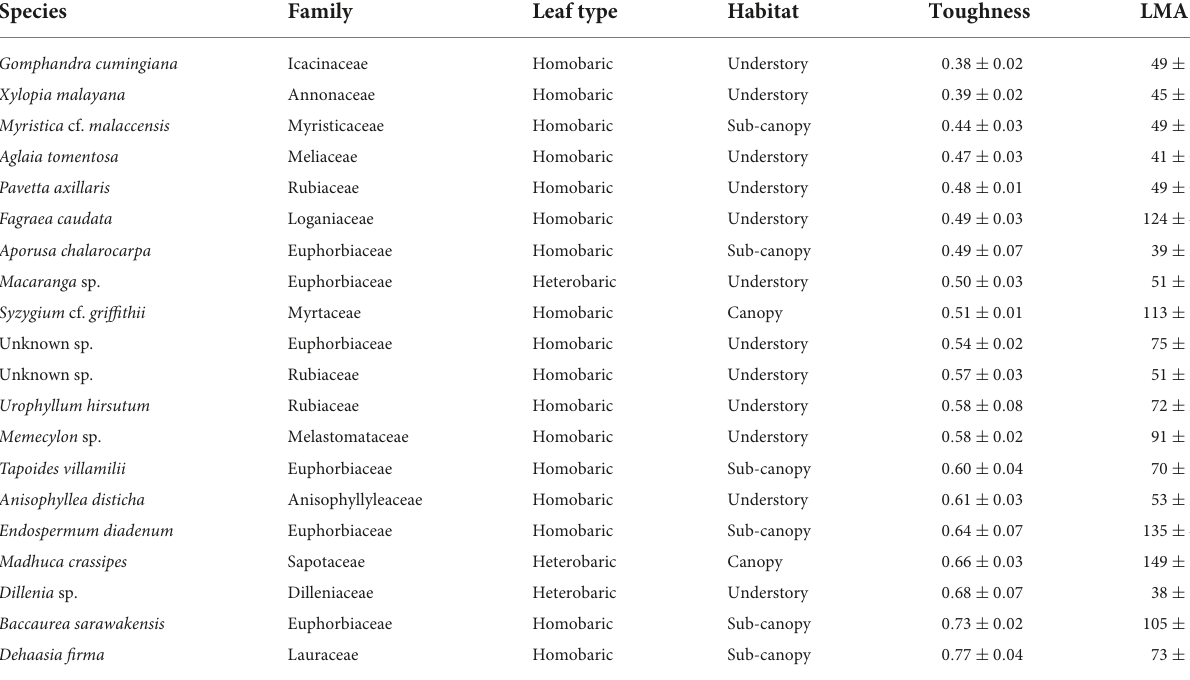
TABLE 3 The 20 species with the lowest leaf toughness, shown in ascending order of average toughness (MPa), and their LMA (g m − 2 ) of three leaves.